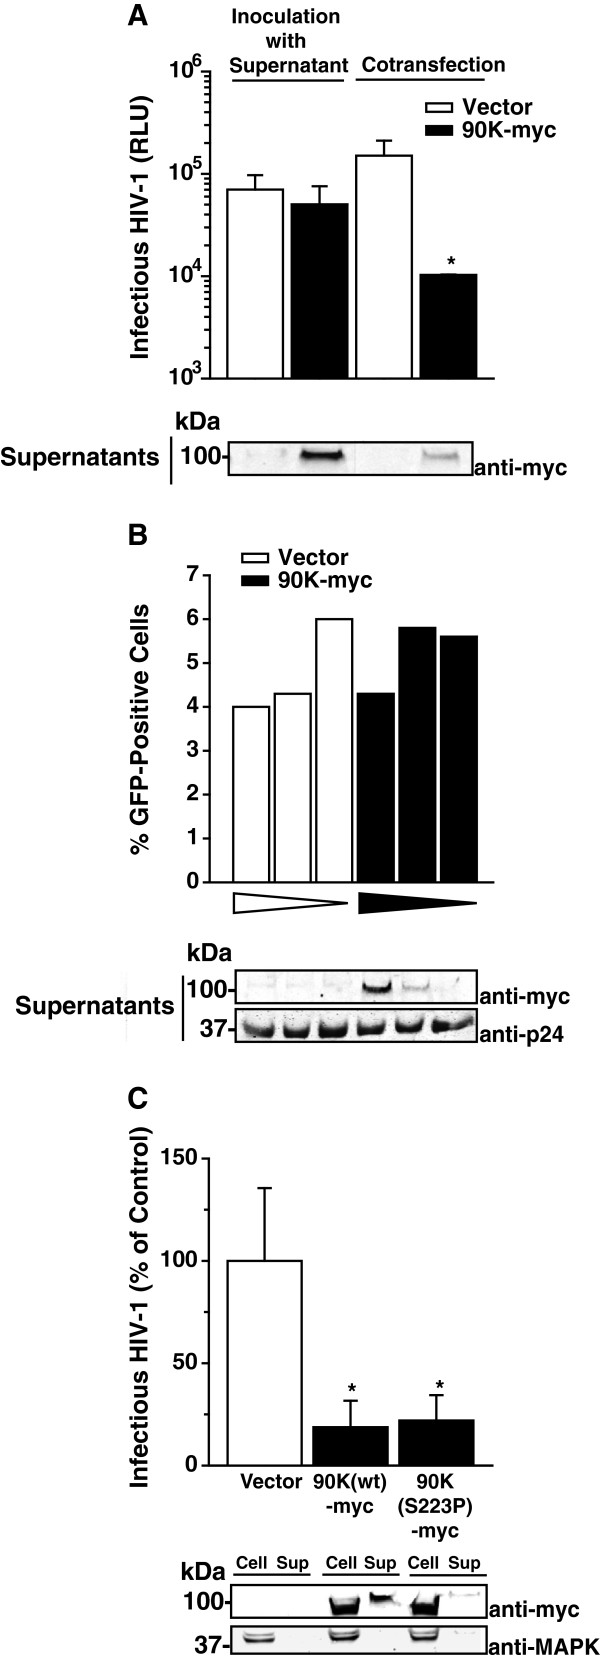
The cell-associated, but not the secreted species of 90K, exerts the antiviral activity. (A) 293T cells were either transfected with pBR.HIV-1 NL4.3 IRES GFP and inoculated with culture supernatant originating from vector-transfected or 90K-myc-transfected 293T cells (left half), or cotransfected with HIV-1 wt and pcDNA6.90K-myc or empty vector (right half). Two days post transfection, the amount of infectious HIV-1 in the culture supernatant was determined. Shown are the arithmetic means ± S.D. of triplicates originating from one representative experiment out of two. Supernatants of the cultures from (A) were analyzed for 90K-myc content. (B) A constant amount of HIV-1 IRES GFP virions was incubated for 15 min at 37°C with decreasing amounts of supernatant derived from 293T cells that had been transfected with empty vector or pcDNA6.90K-myc. TZM-bl were inoculated with the pretreated virus and analyzed for GFP expression three days later. Shown are the values of one representative experiment out of two. An aliquot of the pretreated inoculum that was given to the TZM-bl cells was analyzed by Western Blotting. (C) 293T cells were cotransfected with pBR.HIV-1 NL4.3 IRES GFP and indicated expression plasmids. Two days post transfection, the amount of infectious HIV-1 in the culture supernatant was determined. Values are normalized to the empty vector-cotransfected control. Shown are the arithmetic means ± S.E.M. of three independent experiments. Cell lysates and supernatants from one representive experiment were analyzed by Western Blotting. * : p < 0.05 (Student’s T-Test).